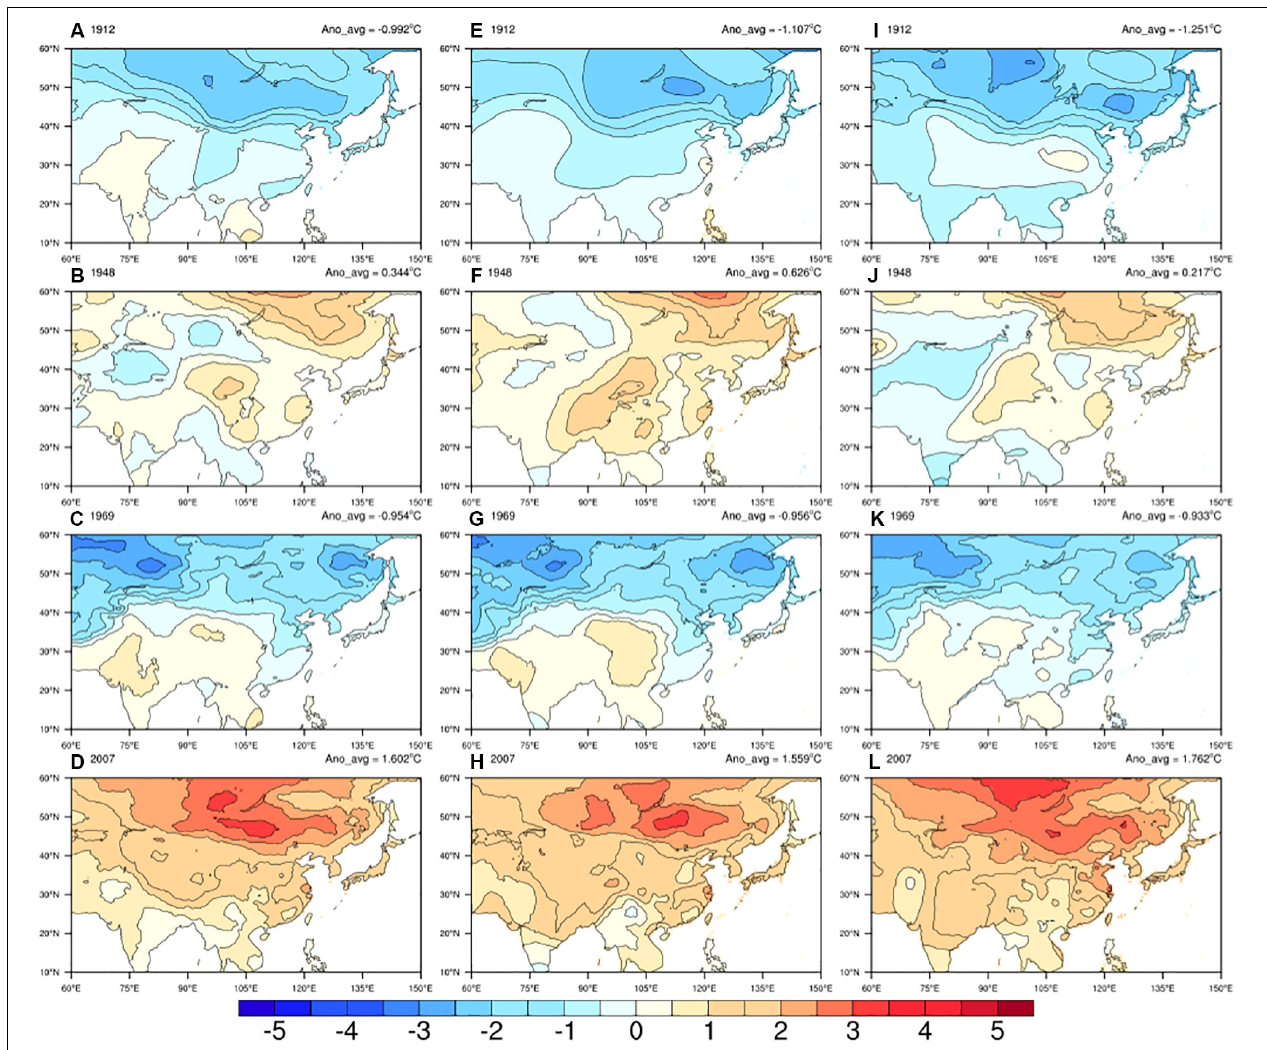
FIGURE 5 | The spatial distribution of the annual anomalies of mean (A–D) , maximum (E–H) and minimum (I–L) LSAT (left to right) of the coldest (1912) and warmest (1948) year before 1950s and the coldest (1969) and warmest (2007) year after 1950s.